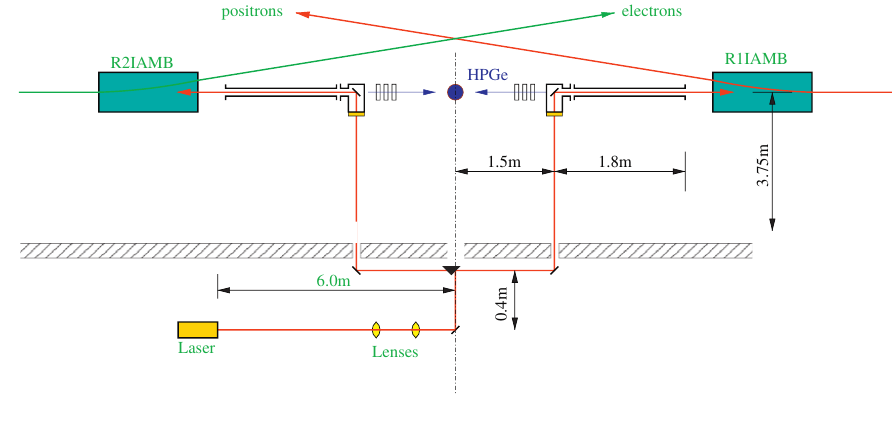
Figure 1. Beam Energy Measurement System